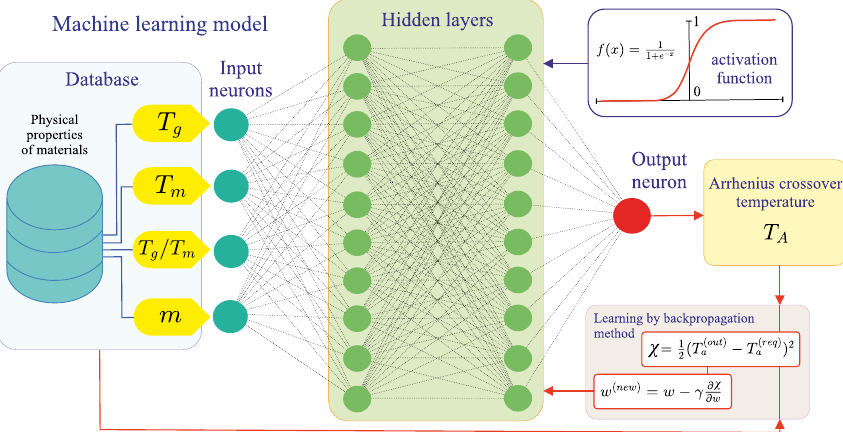
Figure 1. Scheme of the machine learning model based on the feedforward artificial neural